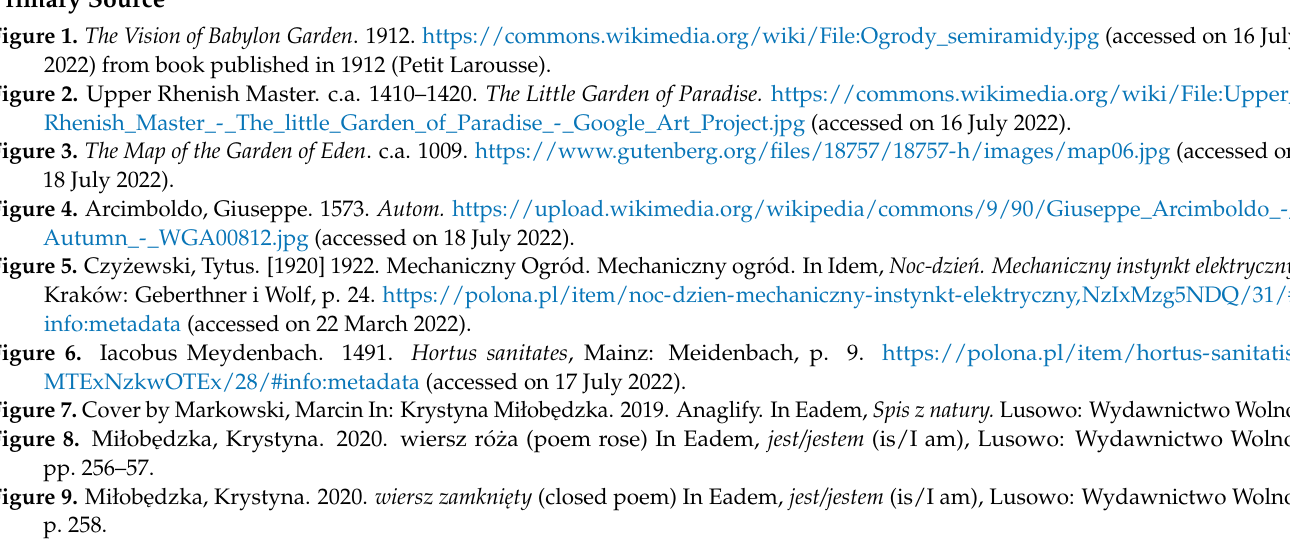
Figure 1. The Vision of Babylon Garden . 1912. https://commons.wikimedia.org/wiki/File:Ogrody_semiramidy.jpg (accessed on 16 July 2022) from book published in 1912 (Petit Larousse). Figure 2. Upper Rhenish Master. c.a. 1410–1420. The Little Garden of Paradise. https://commons.wikimedia.org/wiki/File:Upper_ Figure 3. The Map of the Garden of Eden . c.a. 1009. https://www.gutenberg.org/files/18757/18757-h/images/map06.jpg (accessed on 18 July 2022). Figure 4. Arcimboldo, Giuseppe. 1573. Autom. https://upload.wikimedia.org/wikipedia/commons/9/90/Giuseppe_Arcimboldo_-_ Figure 5. Czy˙zewski, Tytus. [1920] 1922. Mechaniczny Ogr ó d. Mechaniczny ogr ó d. In Idem, Noc-dzie´n. Mechaniczny instynkt elektryczny . Krak ó w: Geberthner i Wolf, p. 24. https://polona.pl/item/noc-dzien-mechaniczny-instynkt-elektryczny,NzIxMzg5NDQ/31/# info:metadata (accessed on 22 March 2022). Figure 6. Iacobus Meydenbach. 1491. Hortus sanitates , Mainz: Meidenbach, p. 9. https://polona.pl/item/hortus-sanitatis, Figure 7. Cover by Markowski, Marcin In: Krystyna Miłob˛edzka. 2019. Anaglify. In Eadem, Spis z natury. Lusowo: Wydawnictwo Wolno. Figure 8. Miłob˛edzka, Krystyna. 2020. wiersz r ó ˙za (poem rose) In Eadem, jest/jestem (is/I am), Lusowo: Wydawnictwo Wolno, pp. 256–57. Figure 9. Miłob˛edzka, Krystyna. 2020. wiersz zamkni˛ety (closed poem) In Eadem, jest/jestem (is/I am), Lusowo: Wydawnictwo Wolno, p.